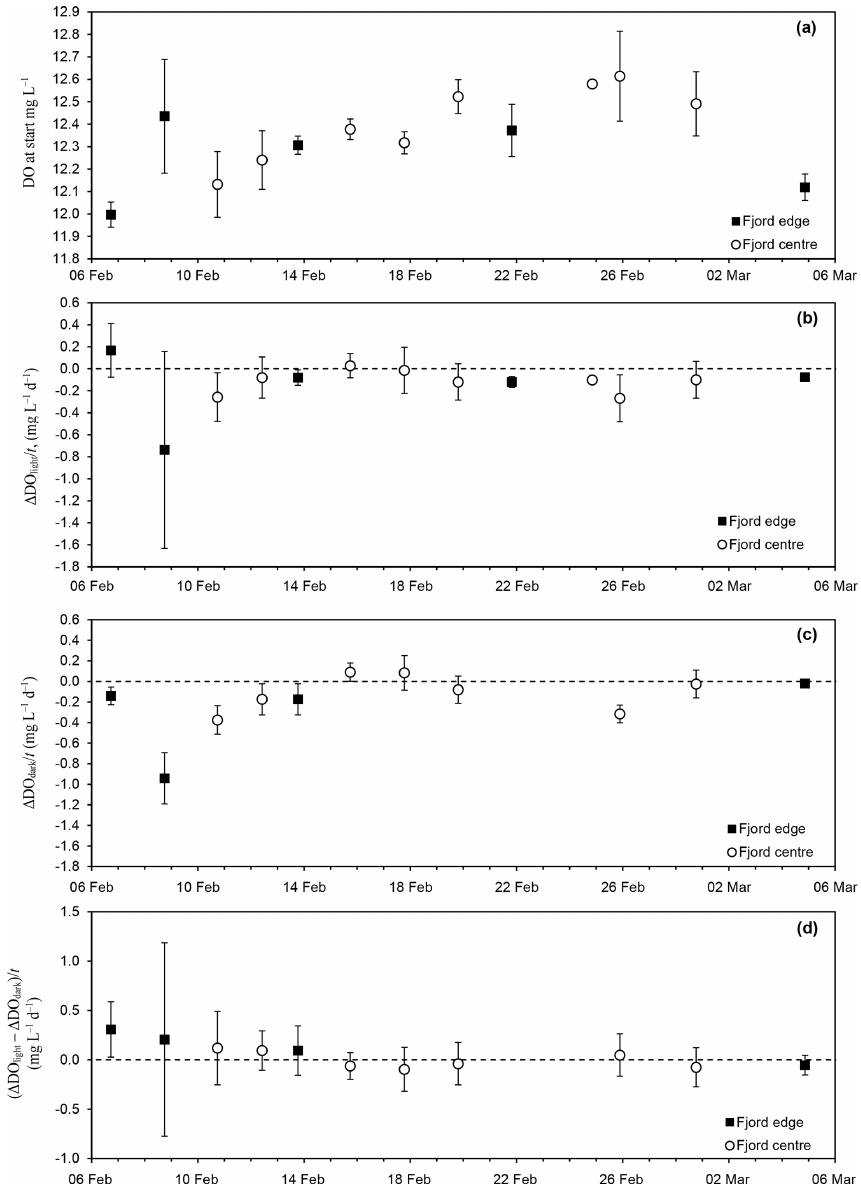
Figure 2. Time series of (a) ambient DO concentration in the seawater at the start of each experiment; (b) rate of change of DO in the light incubation bottles ( (cid:49) DO light /T ), interpreted as the net community production rate (NCP); (c) rate of change of DO in the dark incubation bottles ( (cid:49) DO dark /T ), interpreted as the respiration rate (CR); and (d) the difference ( (cid:49) DO light − (cid:49) DO dark ) /T , interpreted as the photosynthesis rate (GPP). Times are local time in Greenland (UTC − 3) in